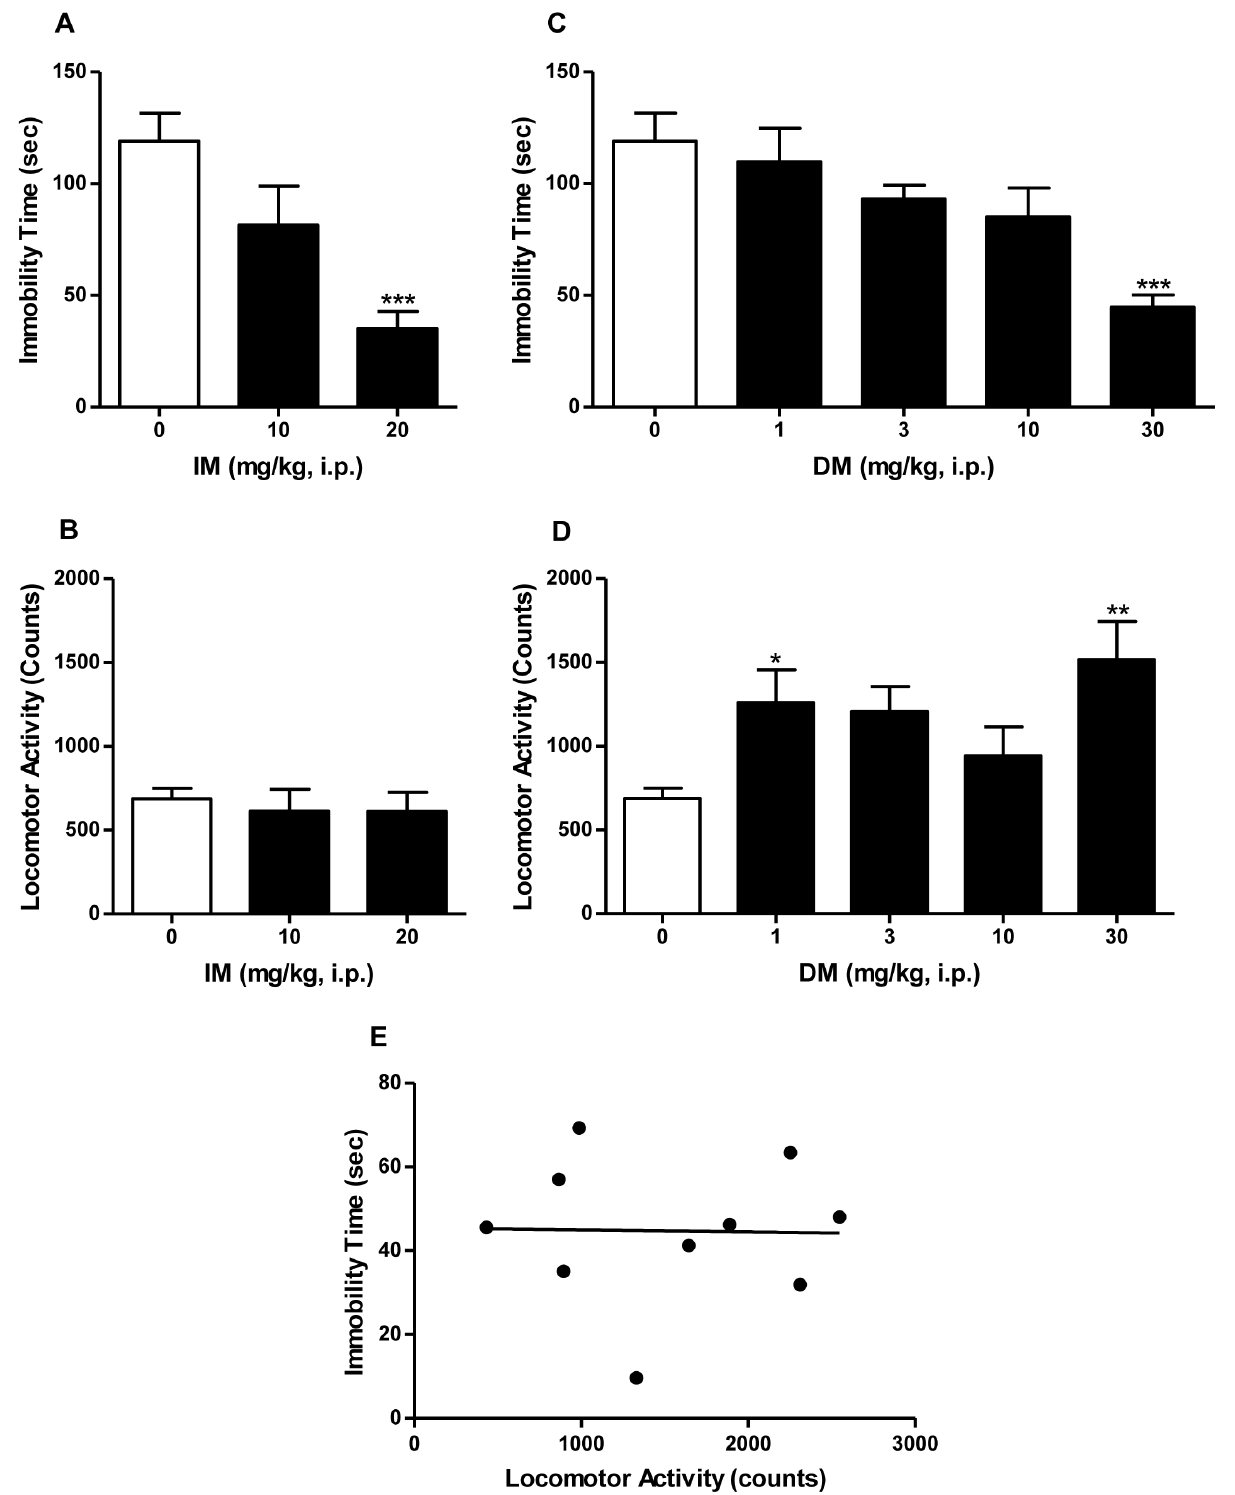
Figure 1. Antidepressant-like effects of imipramine and dextromethorphan in the forced swim test in mice. Imipramine (0–20 mg/kg, i.p.) significantly decreased immobility time (A), but had no significant effects on locomotor activity (B). Dextromethorphan (0–30 mg/kg, i.p.) significantly decreased immobility time (C), and significantly increased locomotor activity (D). However, there was no correlation between dextromethorphan (30 mg/kg)-induced locomotor stimulatory effects and decreased immobility times (E). Data shown are expressed as mean 6 S.E.M. * P , 0.05, ** P , 0.01, *** P , 0.001, compared with the saline-treated group; one-way ANOVA followed by post-hoc Dunnett’s tests. Pearson’s r correlation test for correlation analysis. IM, imipramine. DM, dextromethorphan.